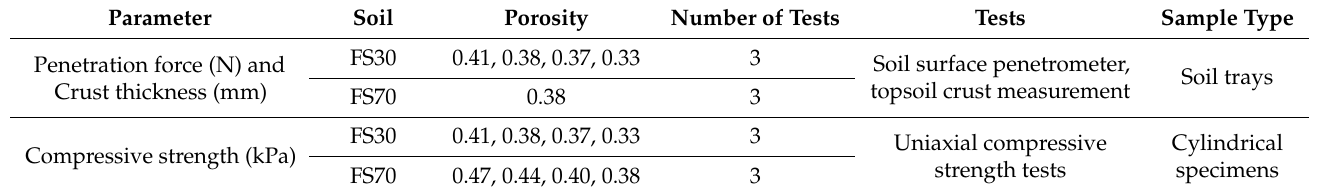
Table 2. Soil porosity for preparation of different soil samples (soil trays and cylindrical specimens).